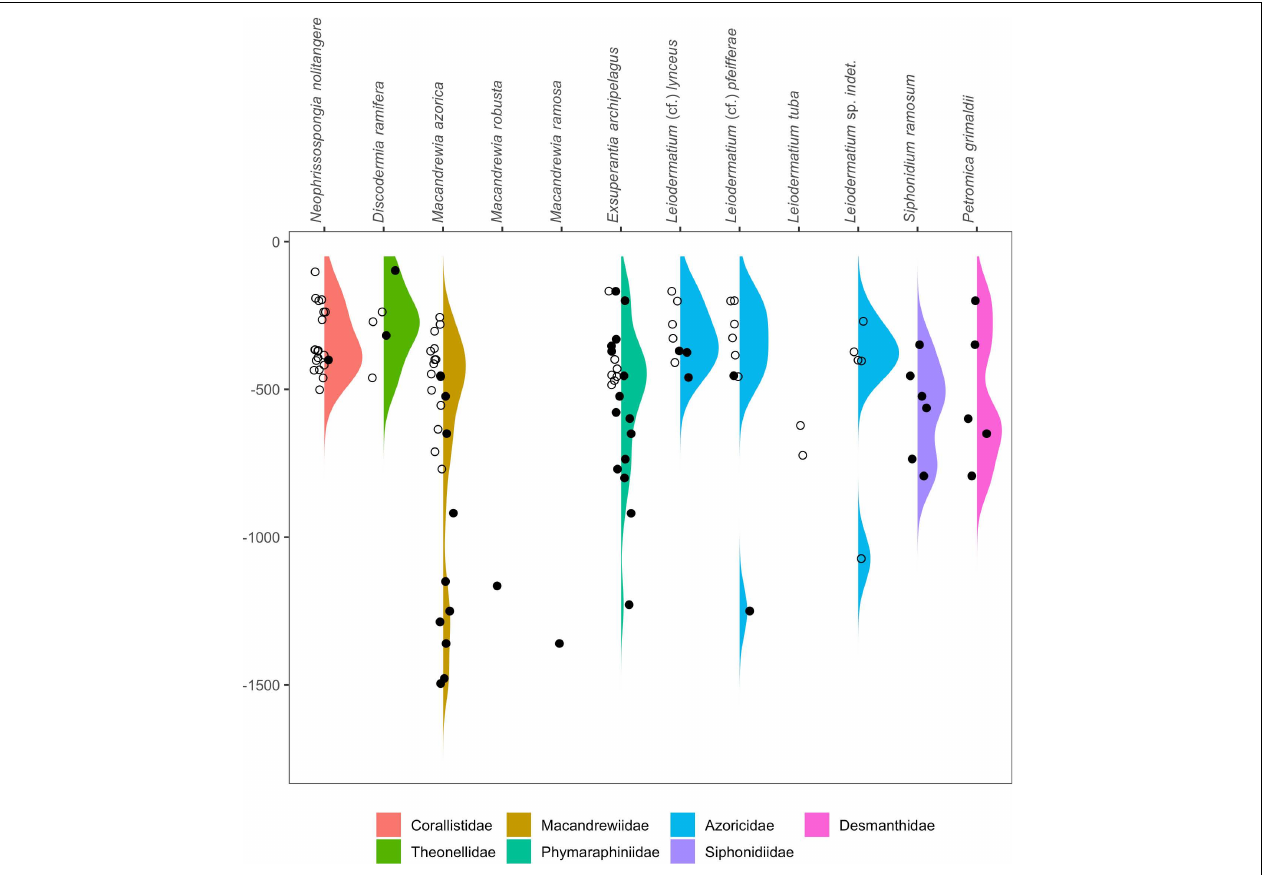
FIGURE 4 | Ridge plots of bathymetric distribution records for each individual species based on georeferenced literature records (closed circles) and analyzed specimens (open circles). Colors correspond to each individual family.